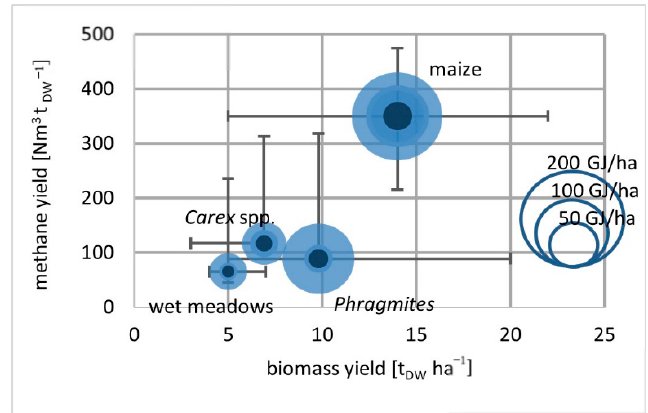
Figure 11. Energy production from the anaerobic digestion (AD) of analyzed feedstocks related to biomass harvest and methane yield. Whiskers show the range of values represented on the x and y axes; blue circles show the energy yield per hectare (compare the legend on the right side of the graph): dark blue—the minimum value; blue—average value; light blue—maximum value (“optimistic scenario”).